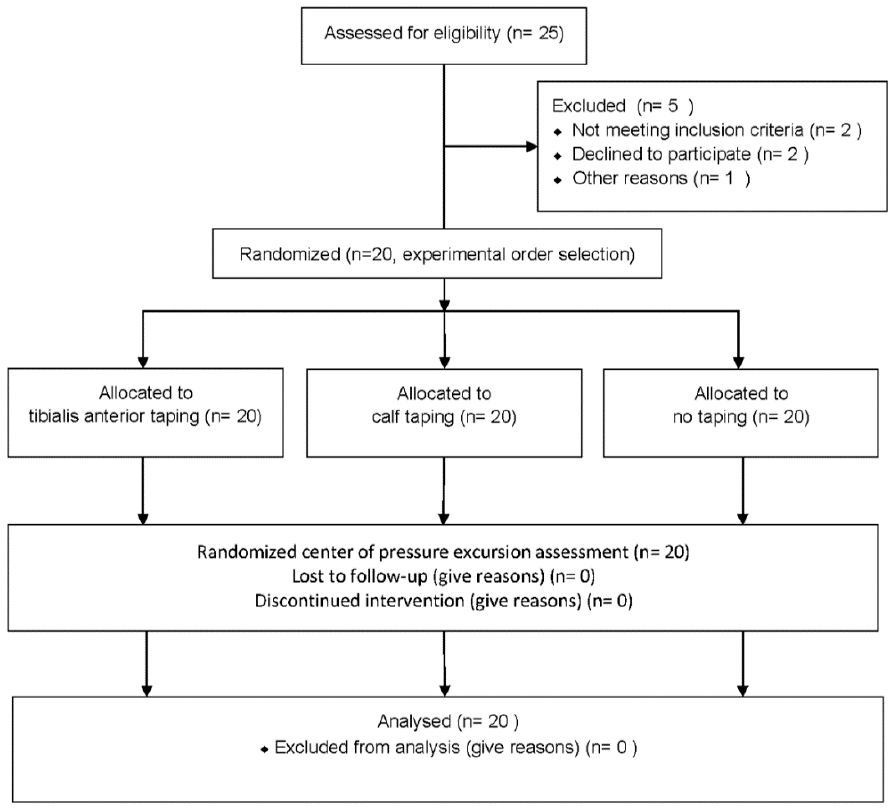
Figure 3. Flowchart of the participant selection.